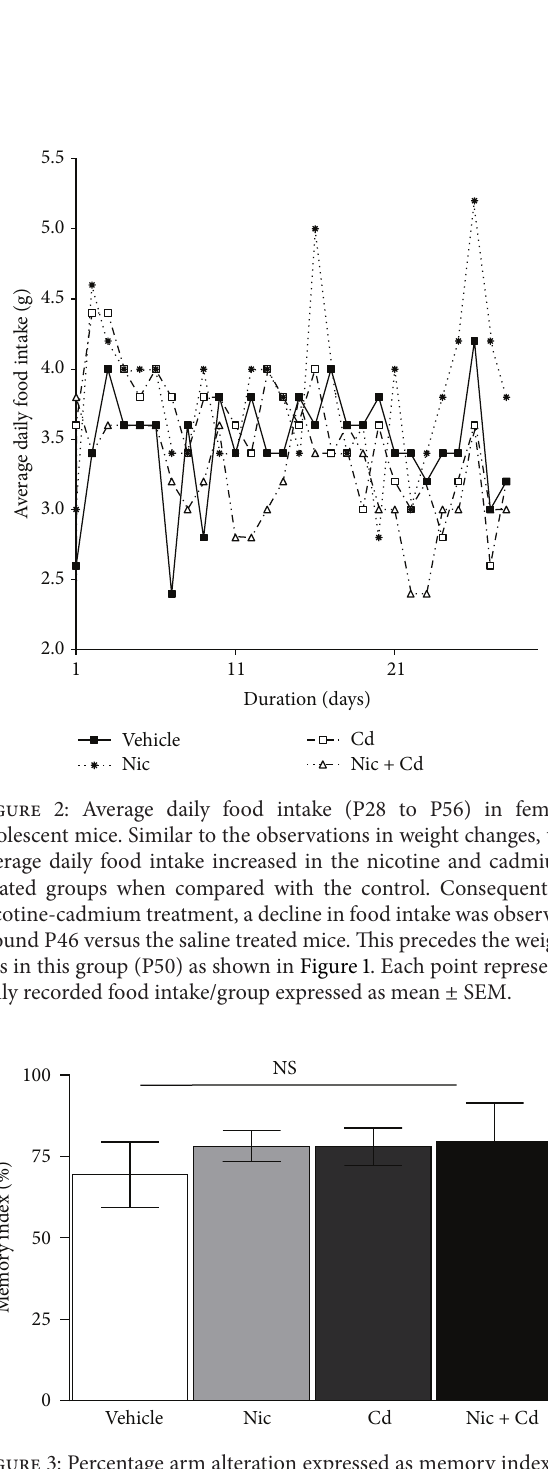
Figure 3: Percentage arm alteration expressed as memory index in Y-maze. No statistical significance was observed in spatial memory function for the treatment groups when compared with the control. Empirically, slight increase was seen in all treatments with the highest recorded in the combined nicotine-cadmium treatment.